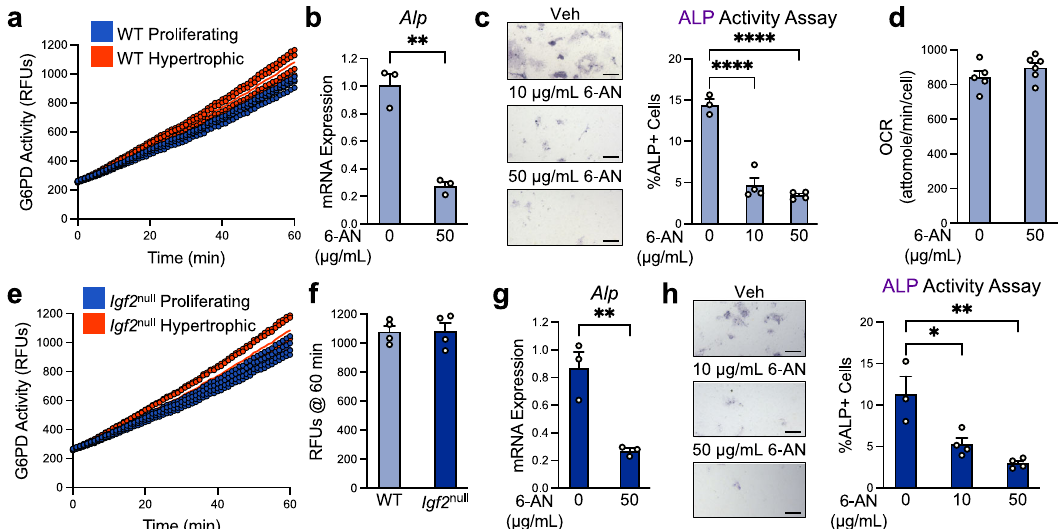
Fig. 6 The pentose phosphate pathway is required for normal hypertrophy in cultured epiphyseal chondrocytes. a G6PD activity measurements in WT epiphyseal chondrocytes under proliferative and hypertrophic conditions. Representative of n = 3 experiments with 3 – 4 wells per group. b Gene expression of hypertrophic marker alkaline phosphatase ( Alp ) as measured by RT-qPCR in WT hypertrophic epiphyseal chondrocytes treated with G6PD inhibitor 6-AN. Representative of n = 2 experiments with 3 wells per group. c WT hypertrophic chondrocytes treated with 6-AN were assessed by staining for alkaline phosphatase (ALP) activity. Representative of n = 3 experiments with 2 – 4 wells per group. Scale bar: 200 µ m. d Baseline OCR measurements of WT epiphyseal chondrocytes under proliferative and hypertrophic conditions and treated with PPP inhibitor 6-AN. Representative of n = 3 experiments with 3 – 6 wells per group. e G6PD activity in Igf2 null epiphyseal chondrocytes under proliferative and hypertrophic conditions. Representative of n = 3 experiments with 3-4 wells per group. f G6PD activity measurements in WT and Igf2 null epiphyseal chondrocytes under hypertrophic conditions. g Gene expression of hypertrophic marker alkaline phosphatase Alp as measured by RT-qPCR in Igf2 null hypertrophic epiphyseal chondrocytes treated with 6-AN. Representative of n = 2 experiments with 3 wells per group. h Igf2 null hypertrophic chondrocytes treated with 6-AN were assessed by staining for ALP activity. Representative of n = 3 experiments with 2 – 4 wells per group. Scale bar: 200 µ m. Data are presented as individual data points with a line indicating the mean ( a , e ) or as individual measurements with mean + SEM ( b , c , d , f , g , h ). Note that the control data (0 µ g/mL 6-AN) for b and g are also shown in Fig. 4. Statistical signi fi cance was calculated by unpaired two-tailed t -test ( b , d , f , g ) or one-way ANOVA with Tukey ’ s test for multiple comparisons ( c , h ). p -values indicated as * p < 0.05, ** p < 0.01, *** p < 0.001, **** p <